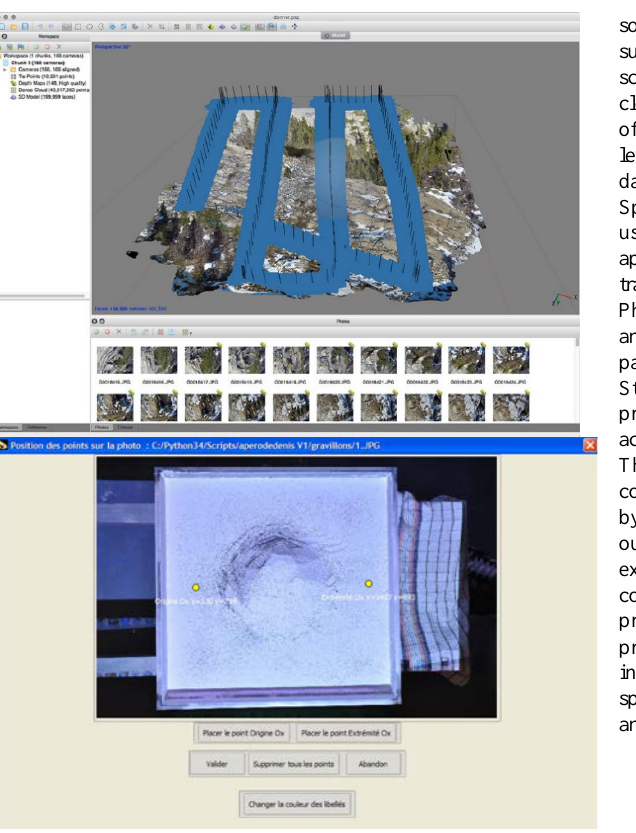
Figure 7. Photoscan, one of the most diffused SfM software and the user friendly Mic Mac interface: